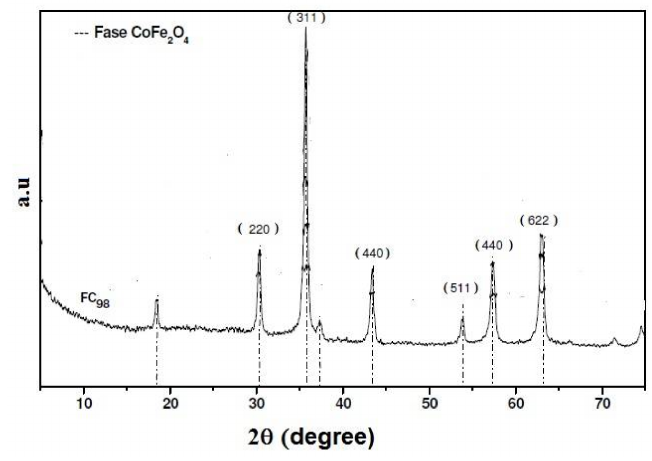
Figure 1. Diffractogram of X-rays of synthesized cobalt ferrites (FCo 98